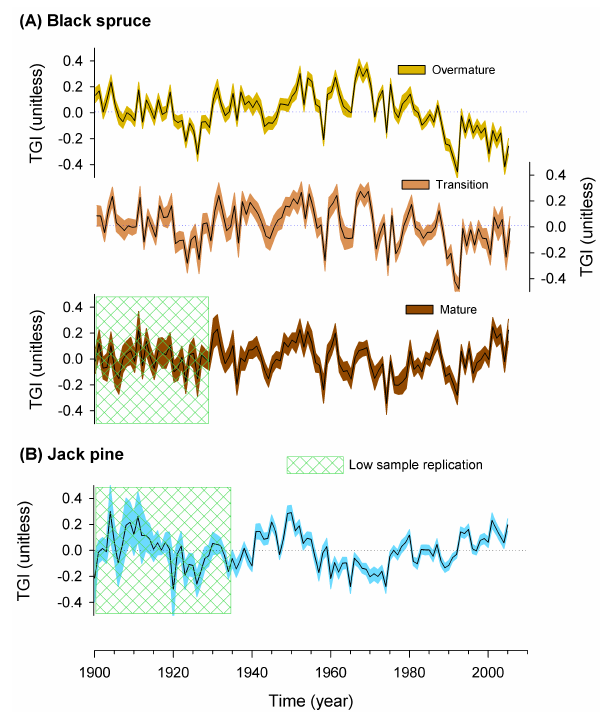
Fig. 3. Eigenvectors of the redundancy analysis (RDA) conducted on the rectangular matrix of 252 plot-level TGI time series using the interval 1950–2005. Climate variable abbreviations are “TEMP” for daytime temperature and “SoilW” for soil water content. The “p” preceding a given month indicates a variable affecting growth the following calendar year. The descriptors (arrows) are positioned in the biplot based on their correlations with the canonical axes (for climate variables, multiply by two). For instance, the variable MayTEMP has a correlation of 0.59 with the first canonical axis and of –0.76 with the second one. In addition, the biplot also ap- proximates the correlation coefficient among TGI time series and climate variables (Legendre and Legendre 1998). Variables with “arrows” at sharp angles are positively correlated (cos 0 ◦ = 1 . 0, i.e. perfect correlation). Conversely, obtuse angles indicate negative correlation (cos 180 ◦ = 1 . 0, i.e. perfect correlation). Eigenvalues (E) and descriptors – climate correlation coefficients are E 1 = 0 . 12, E 2 = 0 . 02, r 1 = 0 . 70, and r 2 = 0 . 72; percentage of explained vari- ance of descriptors – climate relations are canonical axis I = 0.64 and canonical axis II = 0.11. A contour plot of the stand age variable across the two-dimensional RDA space is also shown; the correla- tion between the stand age variable and loading of canonical axis II is 0.52 ( P < 0 . 001).